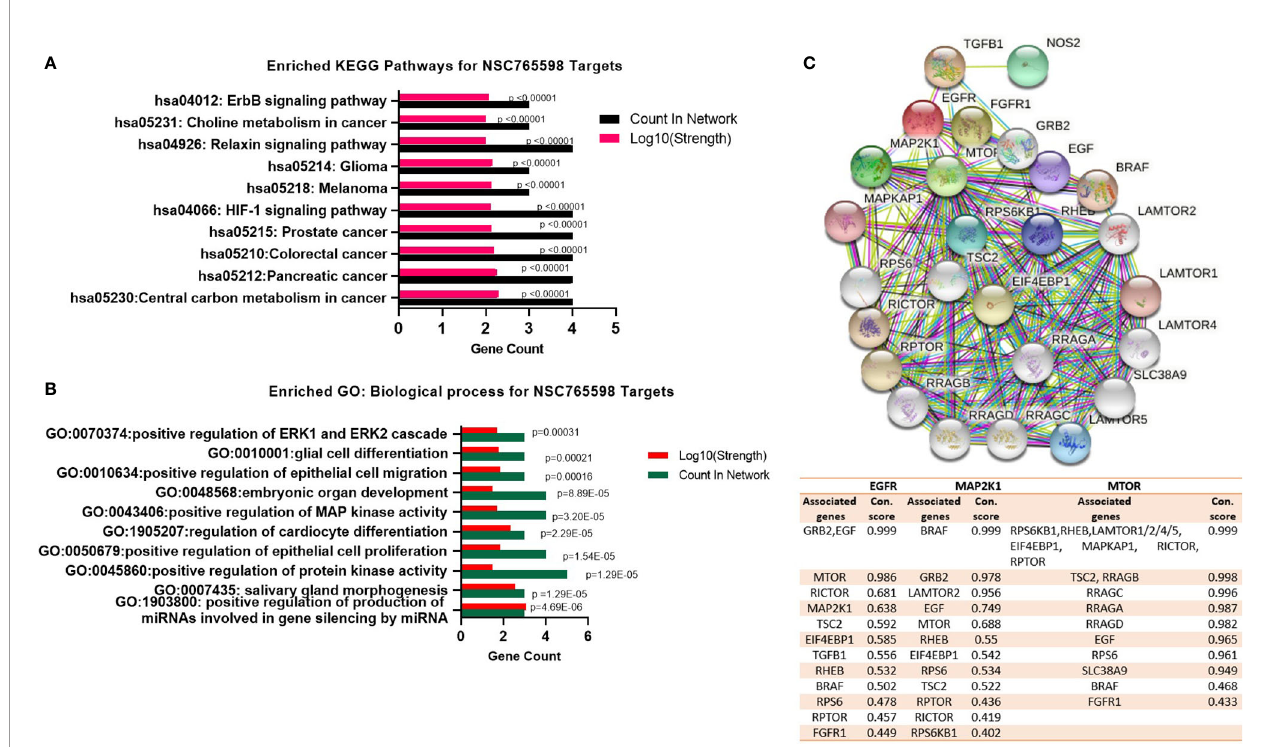
FIGURE 3 | NSC765598 targets are enriched in cancer-associated biological processes and signaling pathways. (A) Enriched Kyoto Encyclopedia of Genes and Genomes (KEGG) pathway of NSC765598 targets. Enrichment was considered at p < 10-6, a gene count of ≥ 3, and a strength of ≥ 2. (B) Enriched Gene Ontology (GO) of NSC765598 targets. (C) Protein-protein interaction (PPI) network of mTOR/EGFR/iNOS/MAP2K1/FGFR/TGFB1. Second-order clustering of NSC765598 gene targets generated 26 nodes, 176 edges, 13.5 average node degrees, an 0.811 average local clustering coef fi cient, and a PPI enrichment p-value of < 1.0e-16. Hub genes with the highest nodes were mTOR, MAP2K1, and EGFR with 23, 14, and 13 nodes, respectively The accompanying table shows connection scores of nodes with the top three hub genes (mTOR, MAP2K1, and